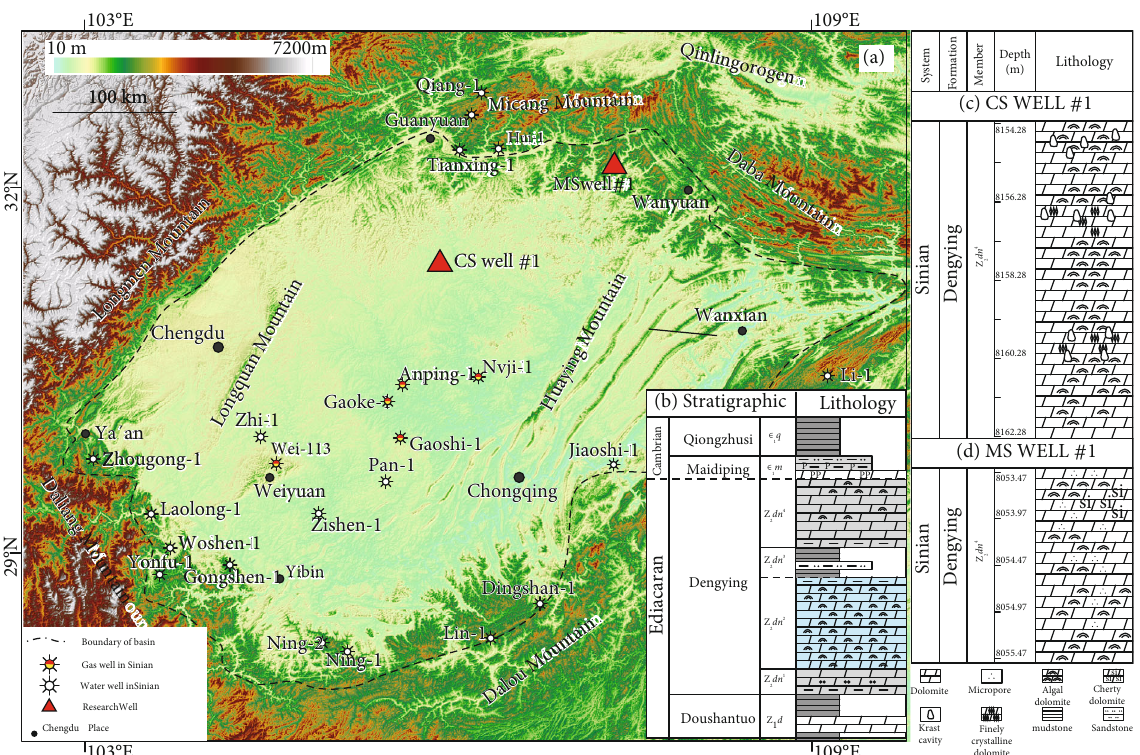
Figure 1: (a) Digital elevation model showing the topography and locations of gas and water wells in the Upper Neoproterozoic Dengying Formation across the Sichuan Basin and surroundings. (b) Lithologic histogram of Dengying Formation of Sinian system in Sichuan Basin. (c) Lithologic histogram of a core section of the Sinian Dengying Formation from CS well #1. (d) Lithologic histogram of a core section of the Sinian Dengying Formation from MS well